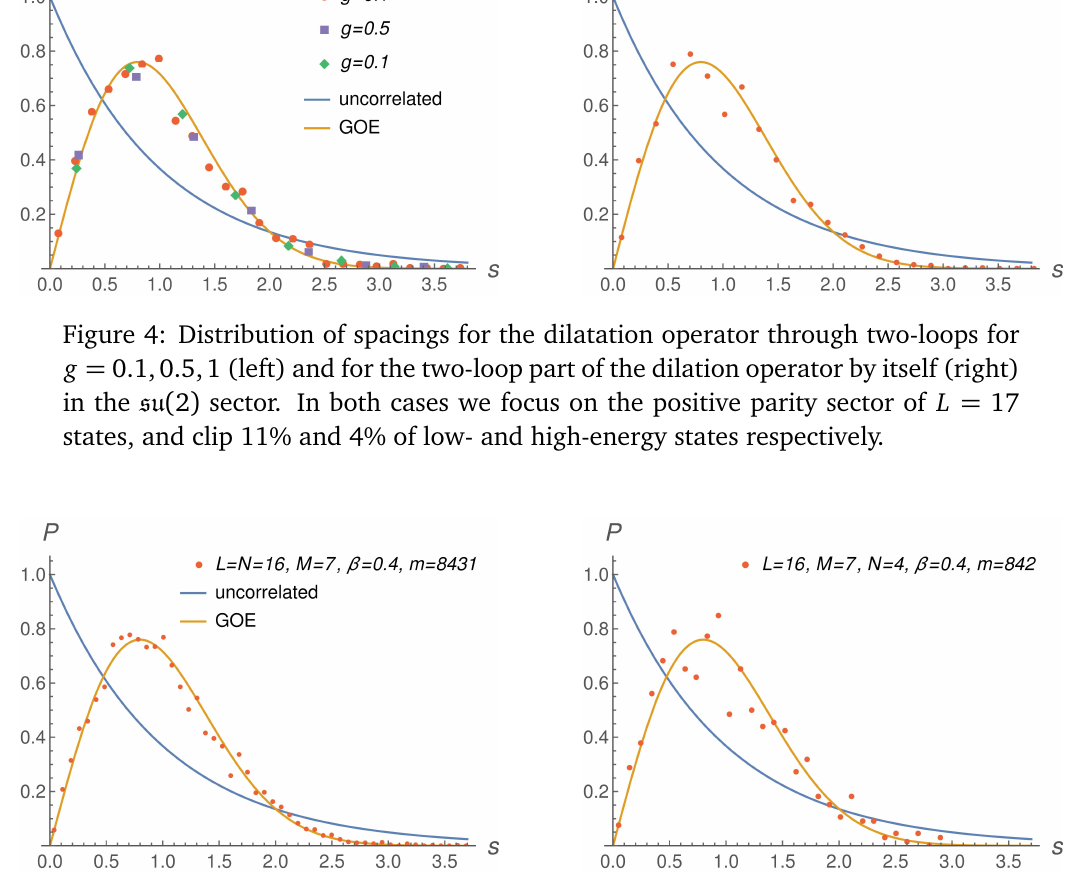
Figure 5: Distribution of spacings (in red) for the β -deformed theory at different values of N , against the GOE distribution (in blue). On the left we consider N = 16, while on the right we focus on N = 4. We clipped 8% (4%) of low-(high-)energy